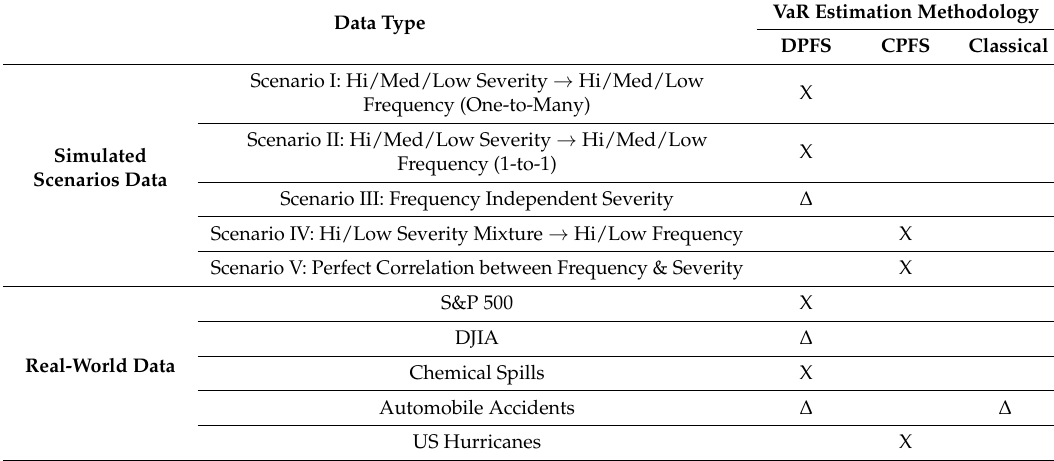
Table 1. VaR results for simulated and real-world data; X indicates this method is most accurate in estimating the true VaR; ∆ indicates that VaR estimation results are indistinguishable within 1% of each